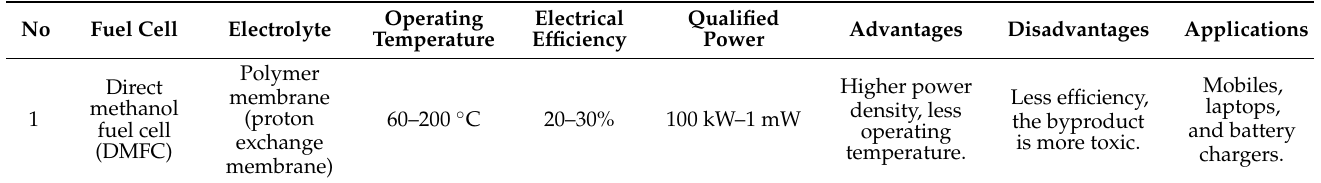
Table 1. List of various types of fuel cells with electrolytes, including operating temperature, electrical efficiency, power range, advantages, disadvantages, and possible applications [42–44].